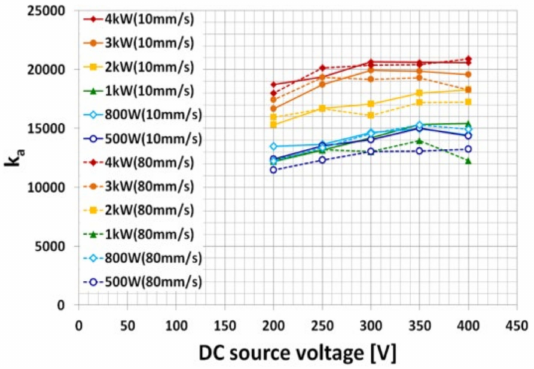
Figure 7. Arc empirical constant k a under separation speed, source voltage, and load power levels (Source voltage ≥ 200